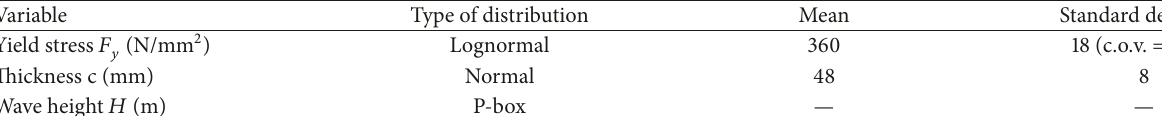
Table 3: Summary of random variables in reliability analysis.